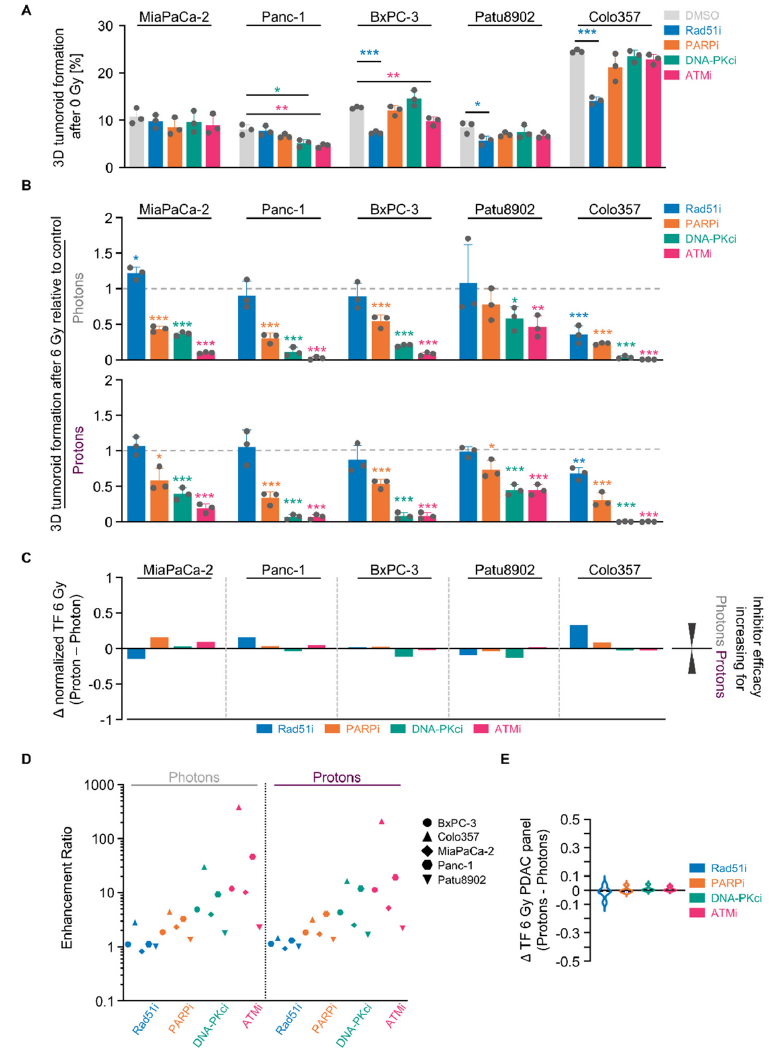
Figure 5. Targeting NHEJ-associated enzymes seems generally potent to sensitize 3D PDAC cell cultures to photon and proton irradiation. ( A ) 3D tumoroid formation capacity of unirradiated indicated PDAC cells treated with indicated DNA repair inhibitors (experimental set-up shown in Figure S2A); ( B ) Normalized 3D PDAC tumoroid formation capacity upon 1-h inhibitor pretreatment combined with 6-Gy photon or proton irradiation; ( C ) Differences in in the radiosensitizing efficacy of inhibitors visualized by Δ values of normalized tumor formation capacity (tumoroid formation capacity after 6 Gy of protons - tumoroid formation capacity after 6 Gy of photons); ( D ) Enhancement ratio (tumoroid formation capacity after 6 Gy control treatment/tumoroid formation capacity after 6 Gy inhibitor treatment) of each cell line analyzed in B (see Figure S6) after photon and proton irradiation plotted logarithmically; ( E ) Analysis of differences in the radiosensitizing efficacy of indicated inhibitors showing violin blots of summarized Δ values of tumoroid formation capacity from all PDAC cell lines analyzed in Figure S6. All results show mean ± SD ( n = 3; two-sided t -test; *, p < 0.05; **, p < 0.01; ***, p < 0.001); Δ : delta, TF: tumoroid formation.